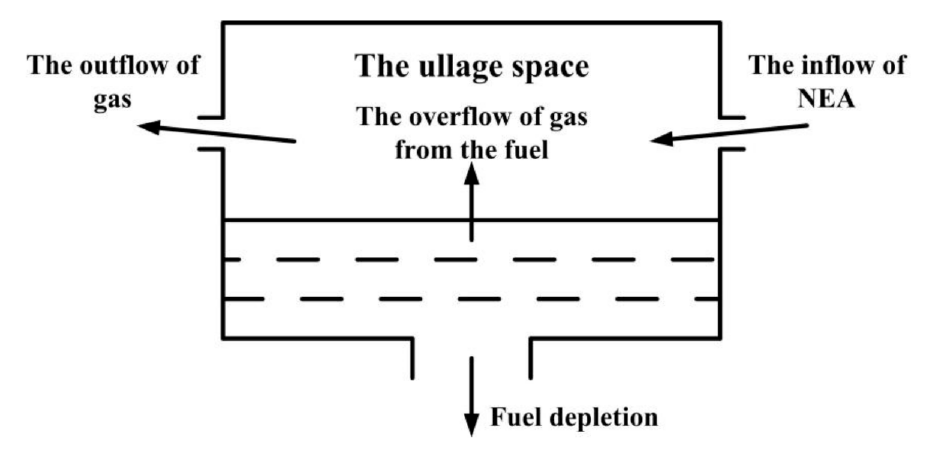
Figure 1. The principle of aircraft fuel tank ullage washing. The dynamic model of ullage washing is established based on the following assump-